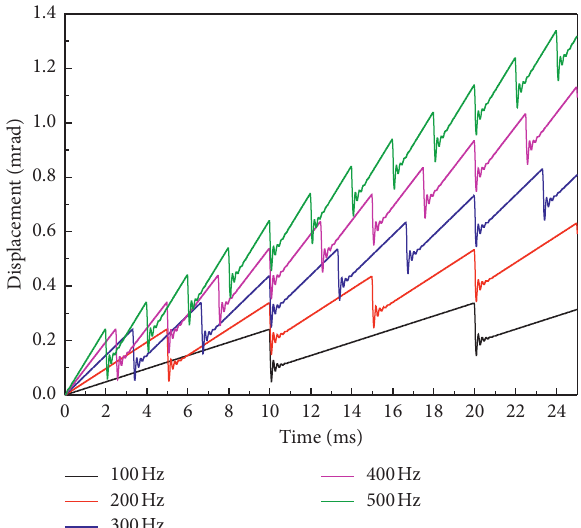
Figure 7: Simulation results of rotation displacement of the PA under 90V sawtooth